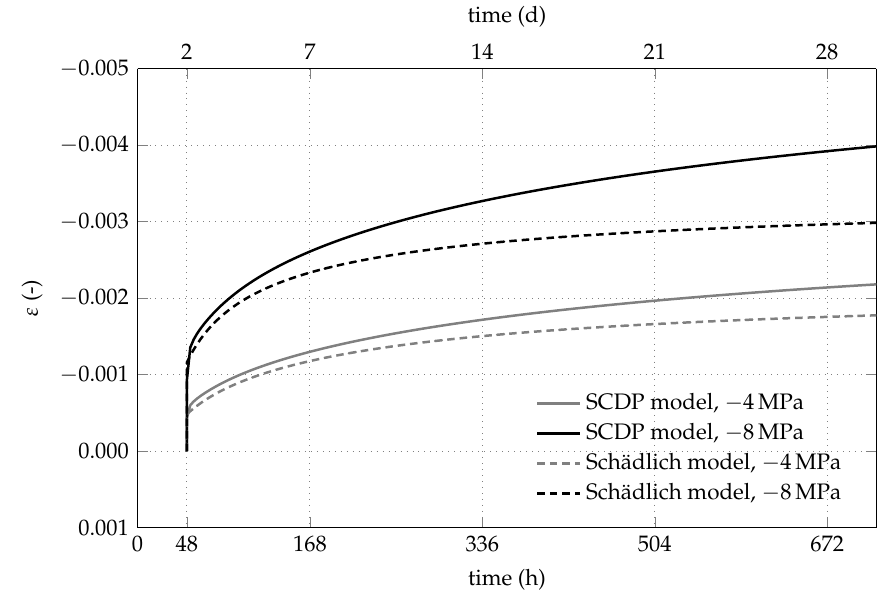
Figure 6. Comparison of the creep behavior, based on the evolution of the total strain, predicted by the SCDP model and the Schädlich model, for sustained compressive stresses of